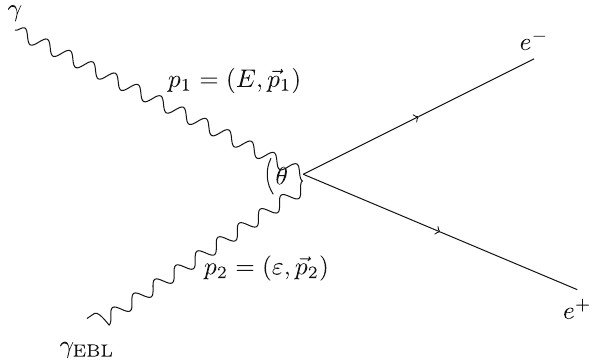
Fig. 1 The diagram of the pair production process: γγ → e − e +